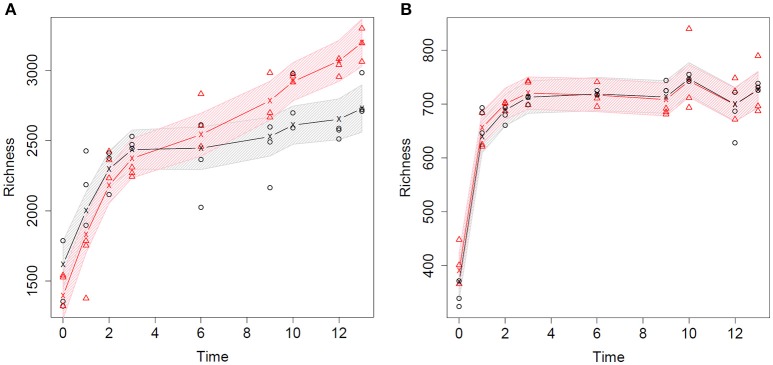
Richness of the microbial community in the strawberry rhizosphere measured over 13 weeks of plant growth. The richness derived from peat and biochar-amended samples are indicated in black and red, respectively. The observed rarified richness's of the biological replicates are depicted with dots. The lines represent the fitted average richness using an additive model with thin plate regression smoothers. The shaded areas are simultaneous 95% confidence bands that are estimated on a grid spanned by the observed time-points (t = 0, 1, 2, 3, 6, 9, 10, 12, 13 weeks). (A) Bacterial community richness of the strawberry rhizosphere. (B) Fungal community richness of the strawberry rhizosphere.